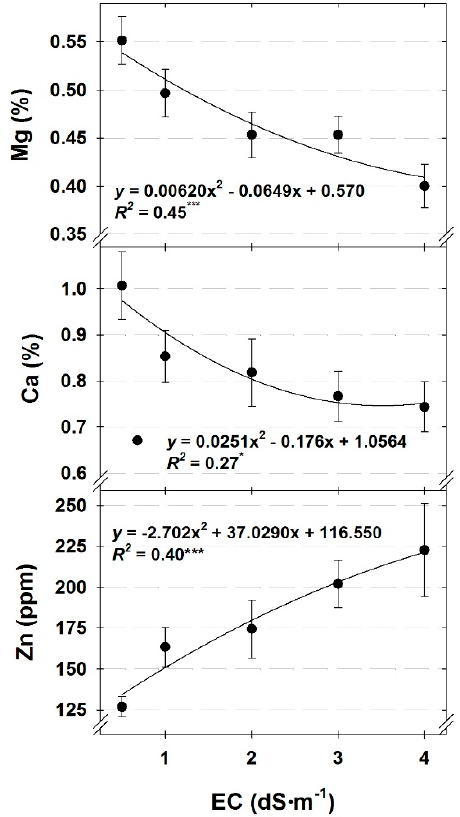
Figure 1. Tissue Mg, Ca, and Zn of cilantro ( Coriandrum sativum ‘Santo’) 4 weeks after transplanting into nutrient-film technique hydroponic systems in a greenhouse under a low (~7 mol · m − 2 · d − 1 ) or high (~18 mol · m − 2 · d − 1 ) daily light integral (DLI) with a range of nutrient solution electrical conductivity (EC; 0.5 to 4.0 dS · m − 1 ) treatments. Data were pooled across daily light integrals within EC. Each symbol represents the mean of six replications with ten plants per replicate, and error bars represent the standard errors of the mean of the six replicates. * or *** indicate significant at p ≤ 0.05 or 0.001, respectively.